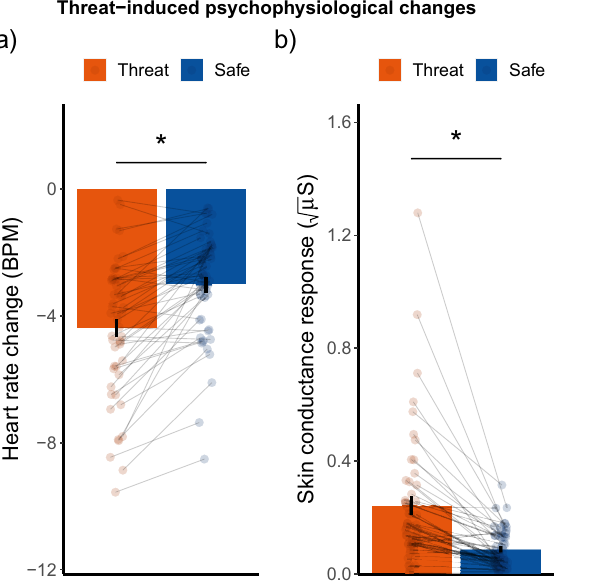
Figure 2. ( a ) The average heart rate change (i.e. baseline corrected) in beats per minute (BPM) and ( b ) Skin conductance responses (SCR)—during threat-of-shock and safe trials. Error bars represent + /− standard error of the mean